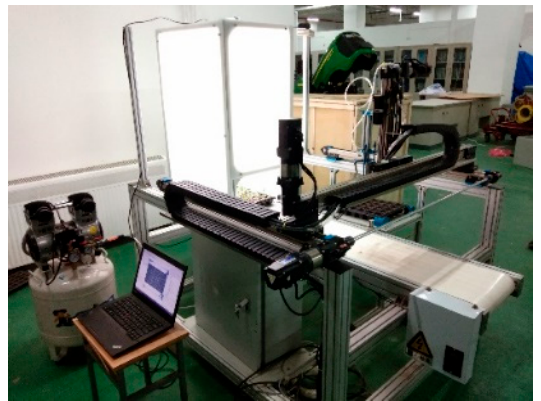
Figure 10. Classification system prototype.